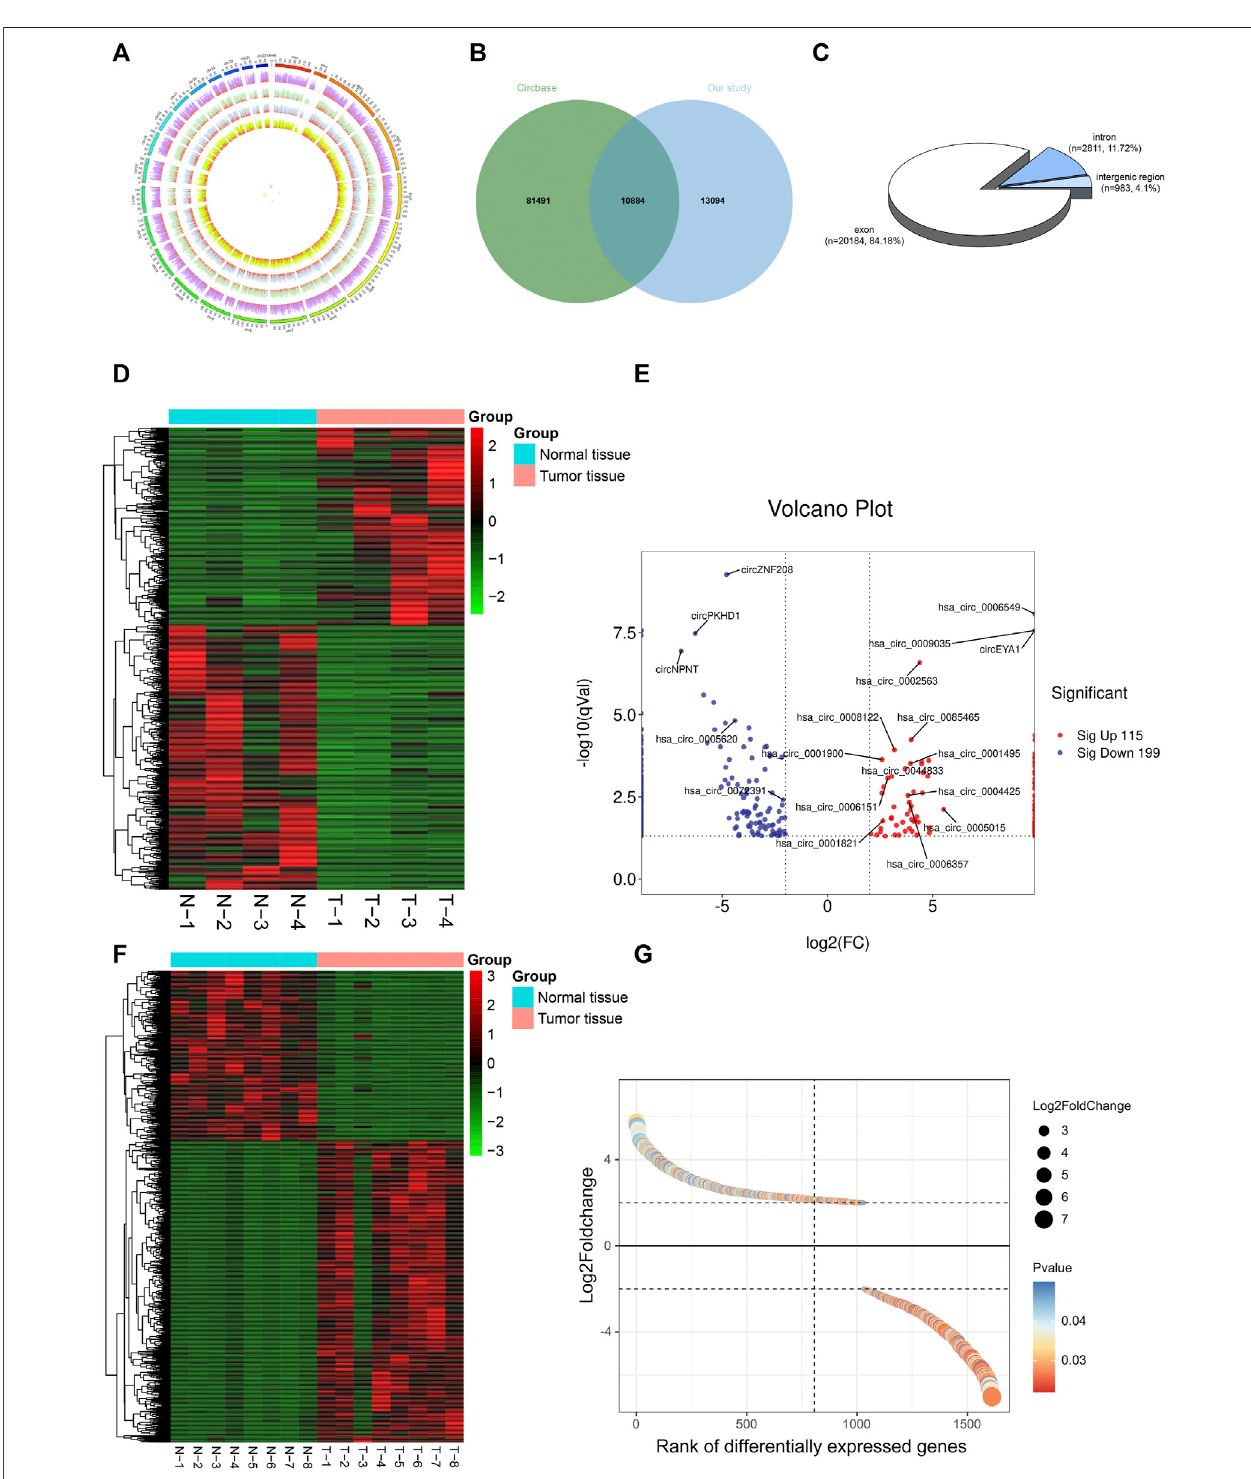
FIGURE 2 | Identi fi cation of DE-circRs and DE-mRs by tumor tissue sequencing in Wilms tumor. (A) The circos fi gure of circRNA global presentation, the outer circle represents chromosomes, inner circle represents samples, and red fraction of each sample represents circRNA junction reads. (B) Wayne fi gure of circRNA sequencing data versus circBase database. (C) circRNAs classi fi cation. (D) Heatmap and clustering analysis of DE-circRs. Each row represents one circRNA and each column represents one sample; -2, -1, 0, 1, and 2 represent fold change. Red indicates high expression and green represents low expression. T represent